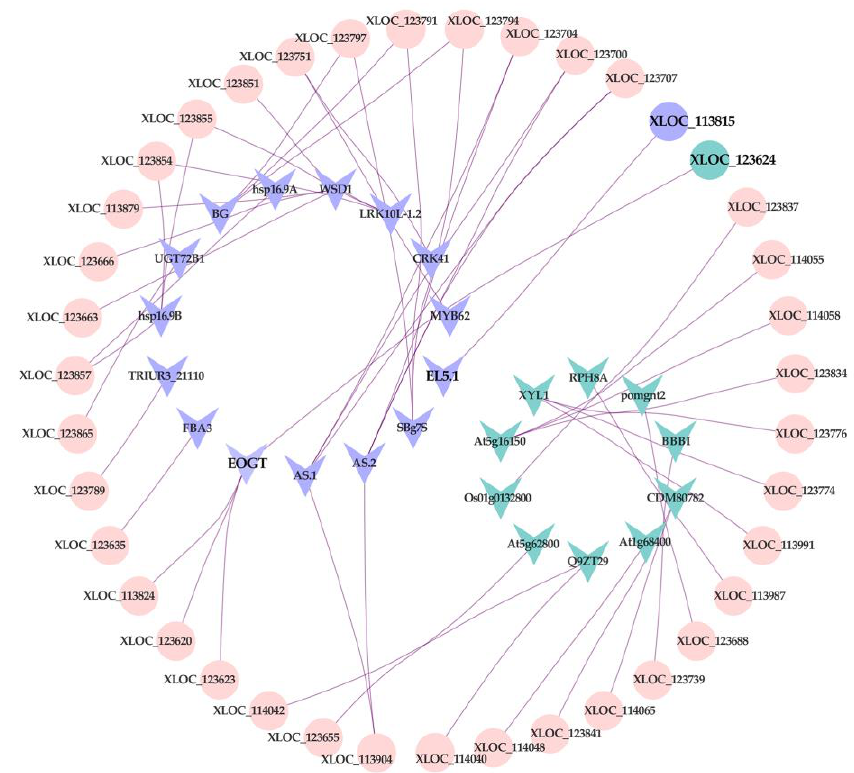
Figure 8. Regulatory network between lncRNAs and putative target genes, cross-validated with the refined meta-QTL 1 / chr 3B of FHB resistance. Round-shape: lncRNA. V-shape: putative target gene. Purple represents upregulation, Blue represents downregulation. Pink represents no significant difference.